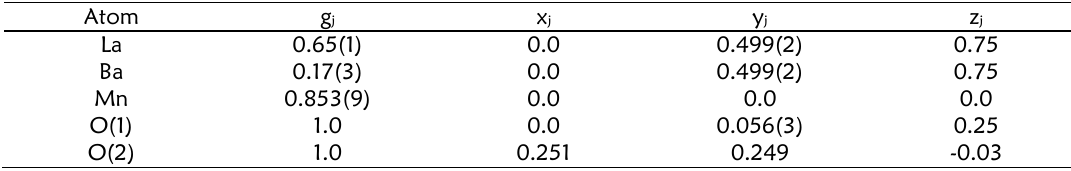
Table 3. The coordinates of atomic fractions (x j , y j , z j ), and atomic occupancy factor (g j ) of S2 sample. Atom